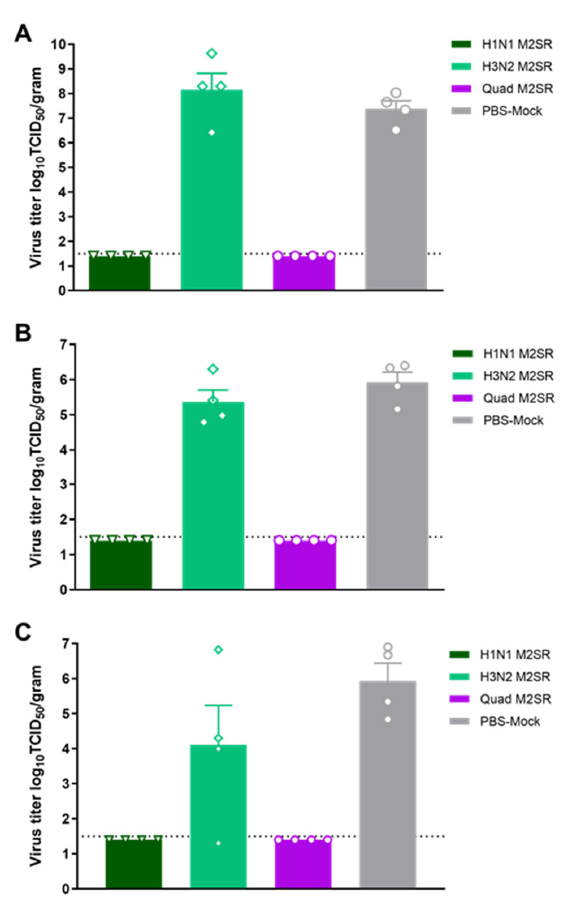
Figure 9. Organ titers from M2SR vaccinated ferrets following a challenge with the H1N1 influenza virus. Nasal turbinates ( A ), trachea ( B ), and lung ( C ) were collected from 4 ferrets per group on day 3 post ‐ challenge. Virus loads in samples were determined by a TCID 50 assay in MDCK cells. Open faced symbols (e.g., triangles, diamonds, circles, etc.) represent virus titers from individual mice within the group, while colored bars represent the mean titer for the indicated group. The detection limit of the assay was 1.5 log 10 TCID 50 /mL, as indicated by a horizontal dotted line.